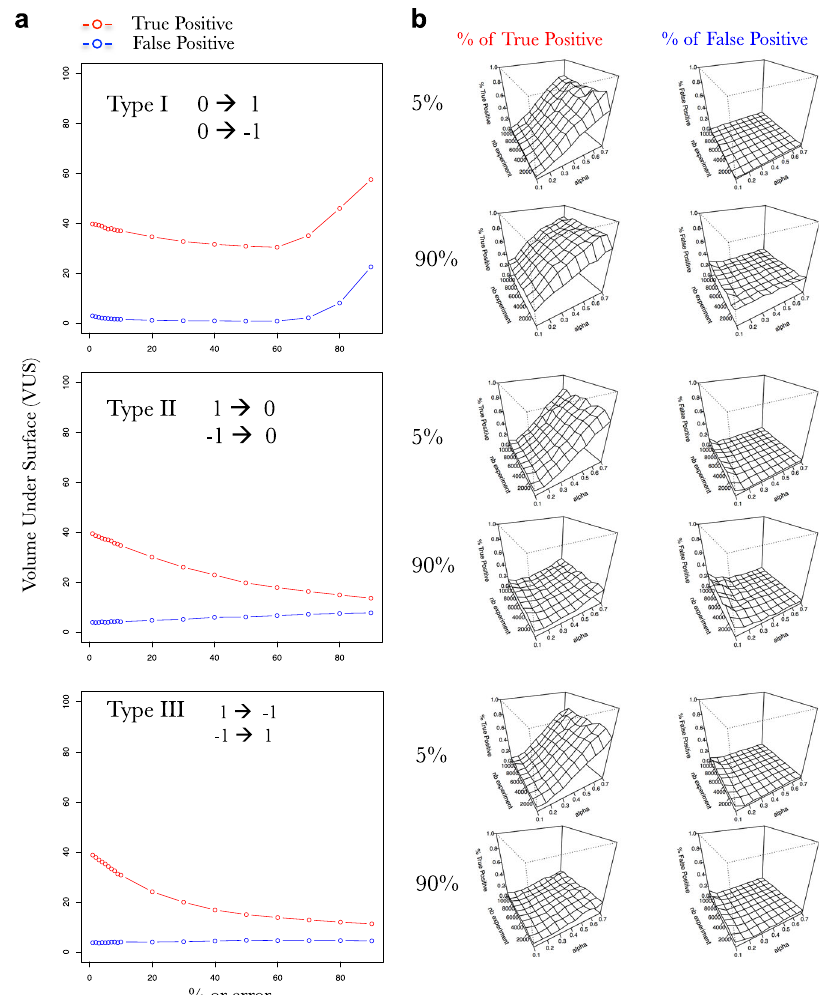
Fig. 9 SVM learning is resilient to prior knowledge containing mistakes of type I. a Three error types have been de fi ned and proposed to SVM: type I (simulates false positive data); type II (simulates false negative data); and type III (wrong-sign in fl uences). Progression of the volume under the surface computed for a progression of % of Type I – III errors fed as prior knowledge. b Surfaces exploring the SVM accuracy (% of true positive on left and % false positive in right ) to predict the connections in a FRANK generated network (100 TF, 1000 TA) using an increasing number of simulated gene expressions ( nb experiment ; y -axis) and an increasing fraction of the network as prior knowledge containing errors of three different types ( alpha [rows are used as prior knowledge]; x -axis). True positive ( red ) and the % of false positive ( blue ) predicted connections in the network. Percentage of true positive and false positive are evaluated based on predictions of the presence of an edge and its positive or negative in fl